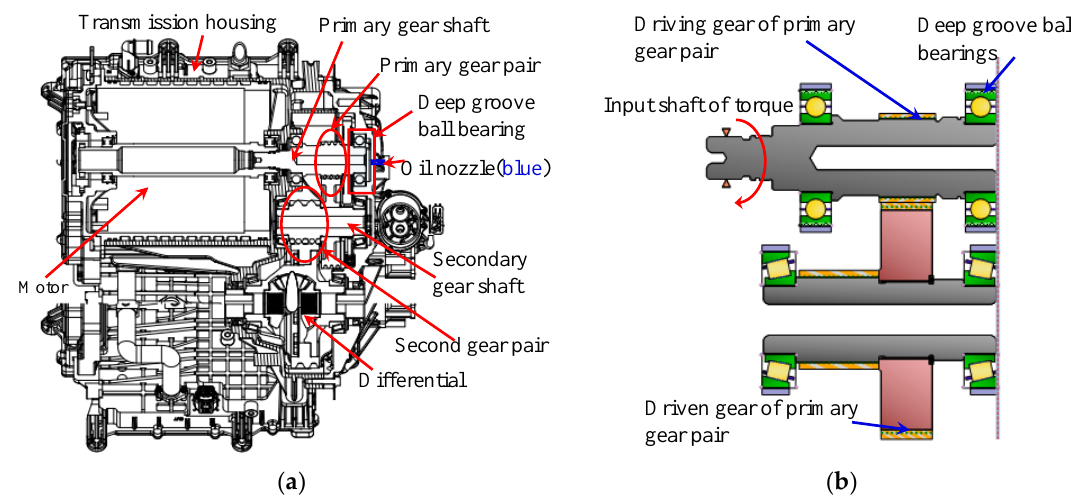
Figure 1. ( a ) Sectional view of the structure of an electric drive system and ( b ) the assembly drawing of primary gear pair.